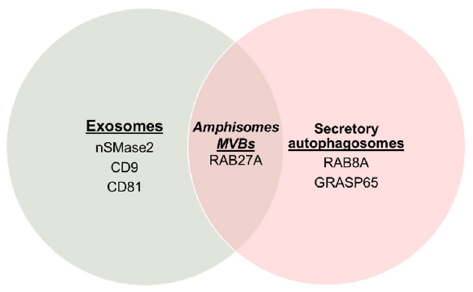
Figure 5: Venn diagram of EVs and associated proteins important in producing JCPyV(+) EVs. Exosomes dependent on nSMase2, CD9, and/or CD81 contribute to JCPyV(+) EV population. Secretory autophagosomes directed by RAB8A and/or GRASP65 produce JCPyV(+) EVs. RAB27A is important in JCPyV(+) EV biogenesis, either in targeting amphisomes and/or MVBs.